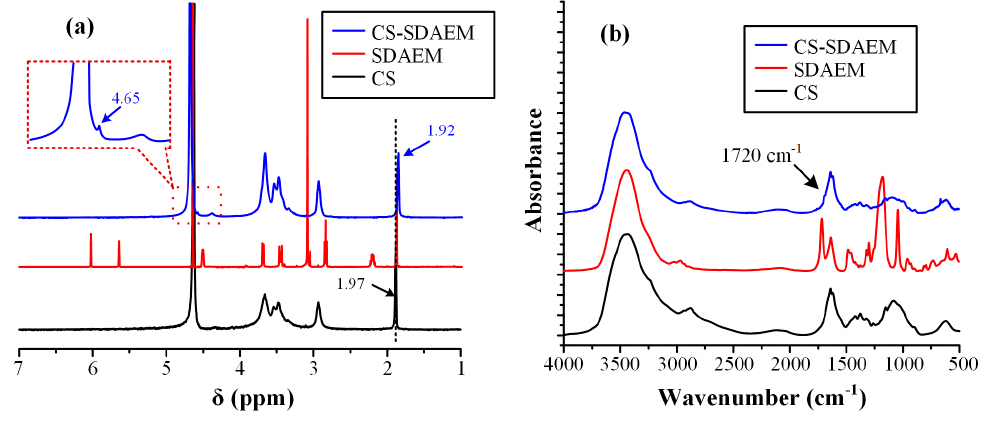
Figure 2. 1 H-NMR spectra ( a ) and FT-IR spectra ( b ) of CS, SDAEM and CS-SDAEM.